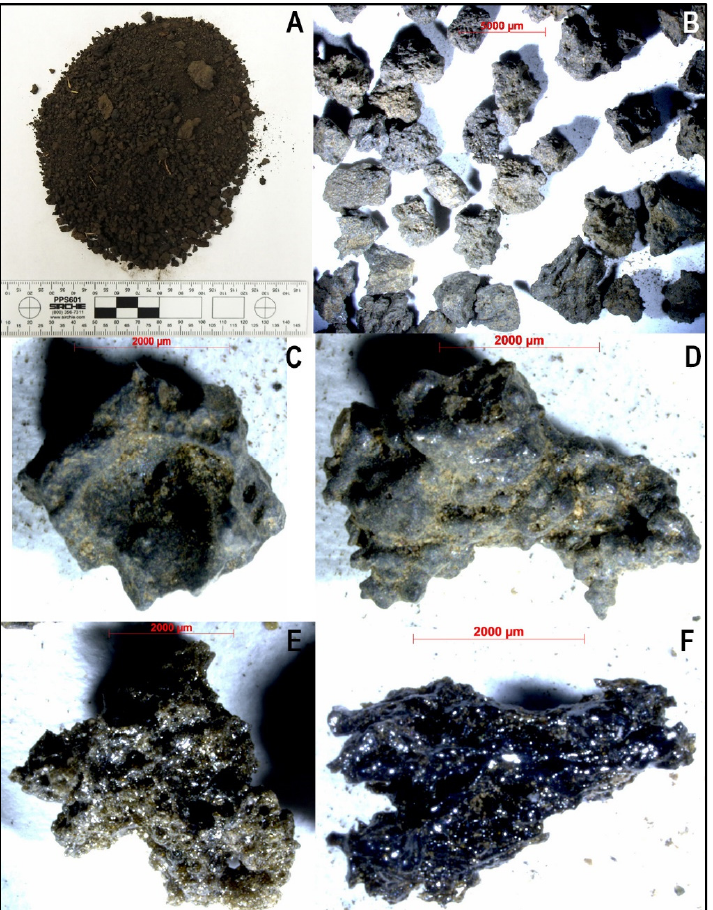
Figure 10. Specimen of volcaniclastic products from the case study area surroundings (sample 1). ( A ) Original sample before treatments. ( B ) Volcanic particles of the fraction retained by the sieve 4 mm, showing high angularity and roughness. ( C ) Sub-spherical particle. ( D – F ) Elongated particles. Elongated particles were glassy and with a vesicular texture and showed high angularity and roughness.